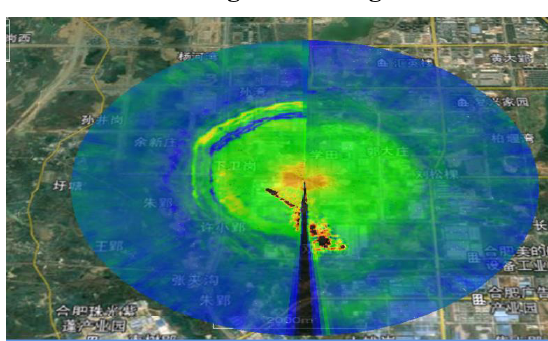
Fig.4 Feb. 10 21:43 Planar Scanning Analysis Chart On February 10, 2018, 21:08-21:43, a